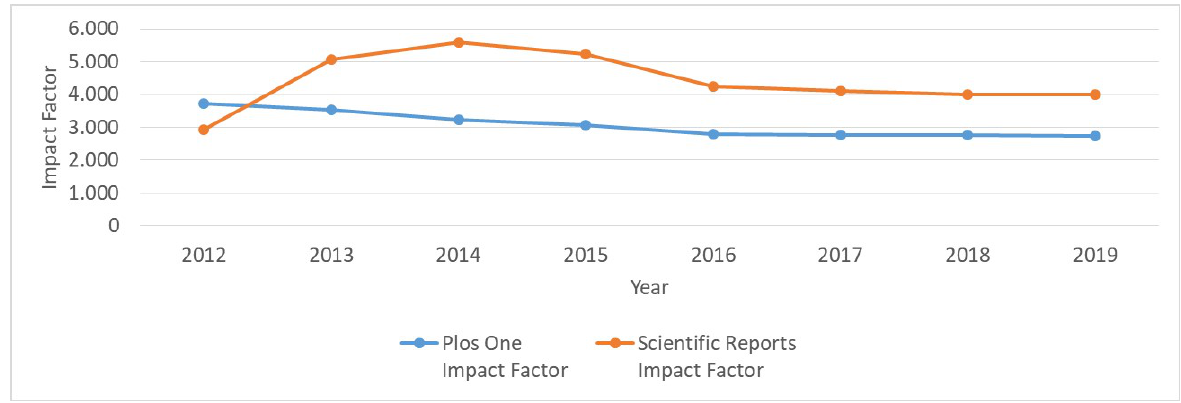
Figure 10. Impact factor evolution from PLoS One and Scientific Reports in the 2012-2019 period. (Source: Incites